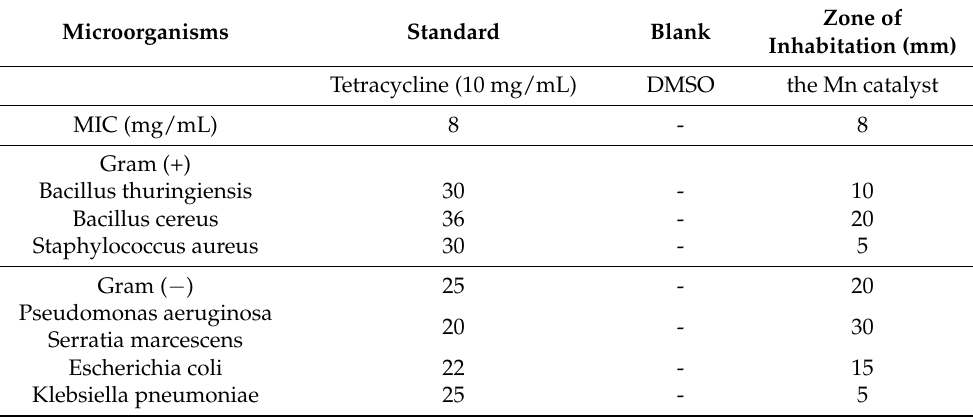
Table 4. Antibacterial activity of Mn-supported nano-catalyst that was expressed as diameter of inhabitation zone (mm) and minimum inhibitory concentration